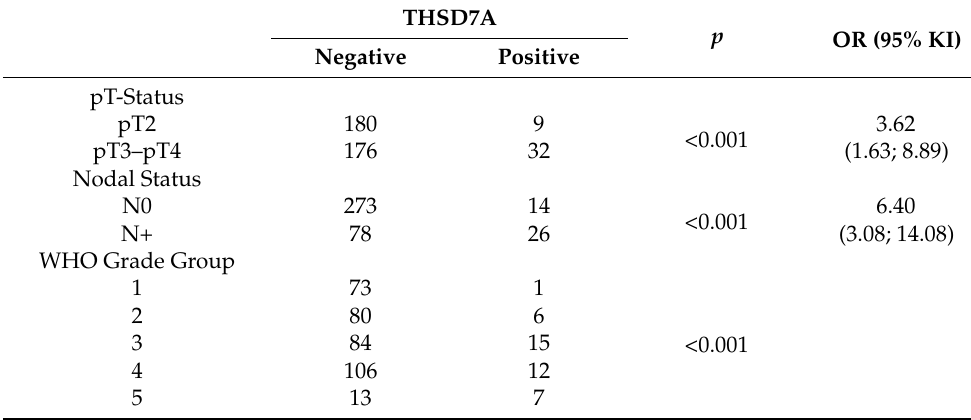
Table 1. Association between THSD7A expression and common pathological